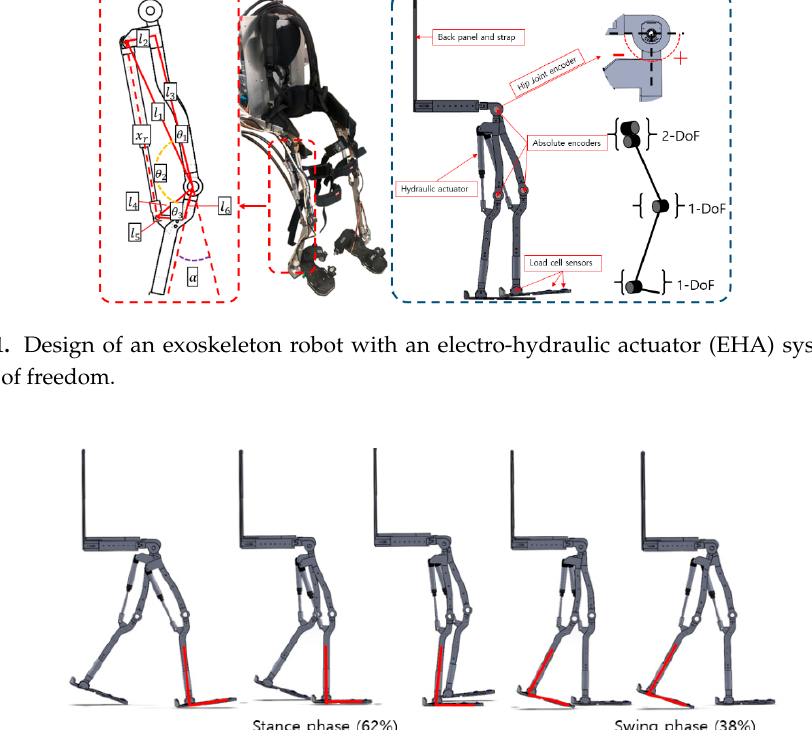
Figure 2. Stance and swing phases in the gait cycle.